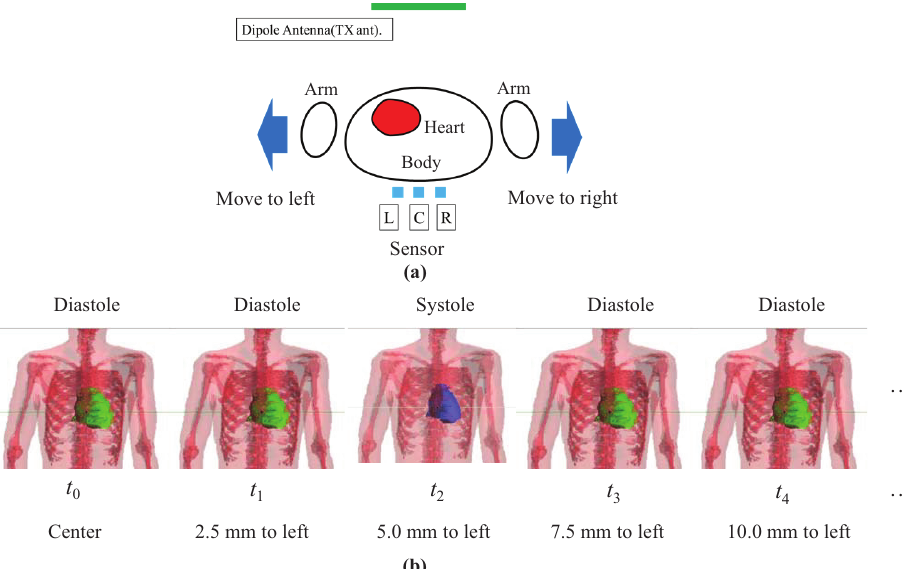
Figure 6. ( a ) Model for simulating the diastole and systole of the heart with body movement; ( b ) Body moving to the